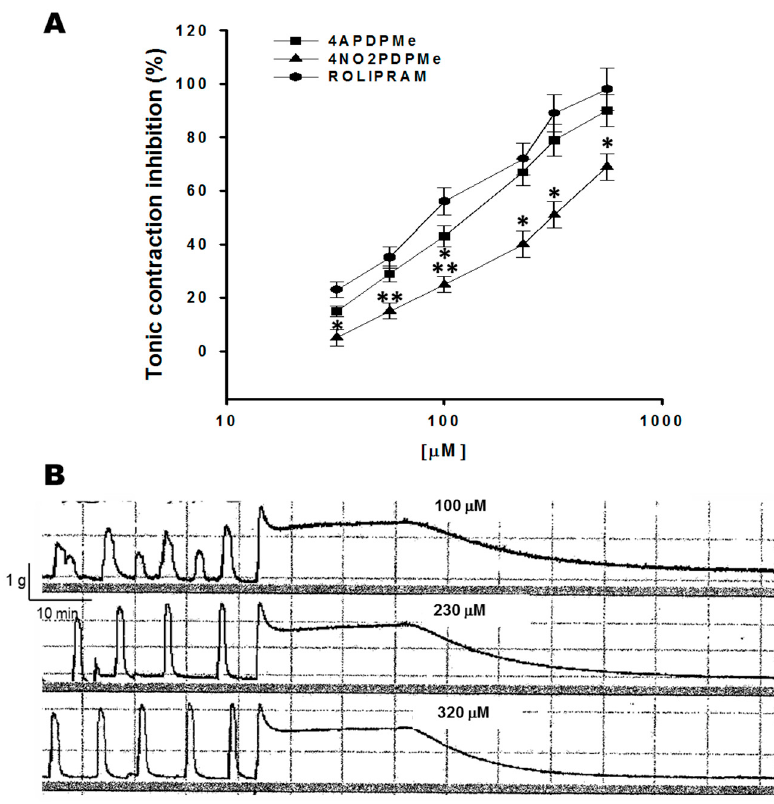
Figure 2. Inhibitory effects of rolipram and thalidomide analogs on the tonic contraction of pregnant human myometrium. ( A ) Concentration-effect curves of rolipram, 4NO2PDPMe and 4APDPMe, on 40 mM KCl–induced tonic contractions of pregnant human uterine strip preparations; each point represents the mean of 6 experiments, and vertical bars indicate the standard error of the mean (±SEM); ( B ) Typical recording of tonic contractions inhibited by a thalidomide analog in a concentration-dependent manner. Difference vs. rolipram, * p < 0.05 or ** p < 0.001. Table 1. Rolipram and thalidomide analog IC 50 and Emax values for myometrial spontaneous and tonic